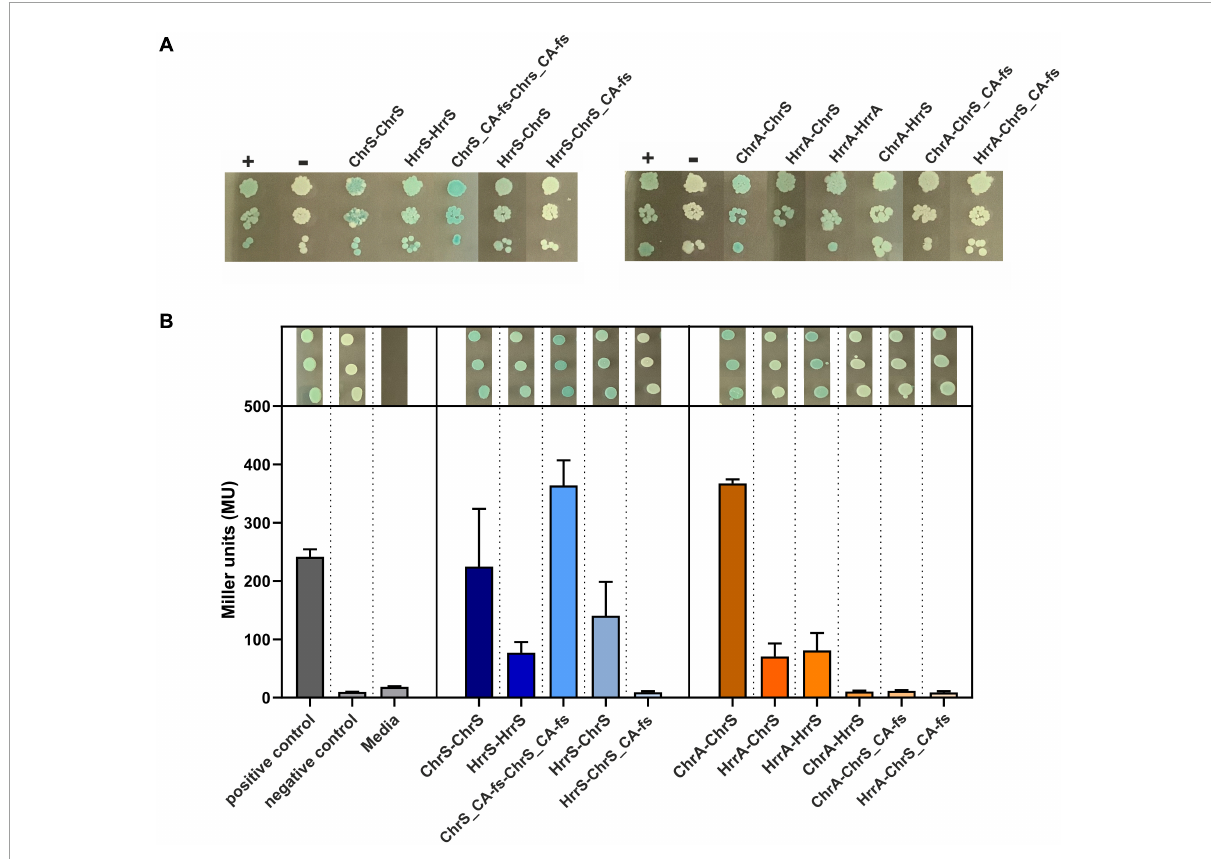
FIGURE5 Bacterial two-hybrid assays of interactions between ChrSA and HrrSA. (A) BACTH interactions between the histidine kinases ChrS, HrrS and the evolved ChrS variant (here ChrS_CA-fs) were analyzed as C-terminal fusions; results for N-terminal variants are shown in Supplementary Figure 7 . Blueish color of the colonies indicate interaction, while white colonies indicate no interaction (Euromedex, Souffelweyersheim, France). First histidine kinase represents the T25-fusion, the second the T18-fusion. + = pKTN25-zip with pUT18-zip (leucine zipper, positive control), – = pKTN25 with pUT18 (negative control). (B) Quantitative analysis using a β -galactosidase assay. Triplicates were cultivated and treated according to Griffith and Wolf (2002) to measure colorimetric β -galactosidase activity (given in Miller units). Gray bars represent the controls, blue bars show the interaction between the histidine kinases, and orange bars show the interaction of histidine kinase with the response regulators. Drop assays on top of the bar plots represent the triplicates picked after